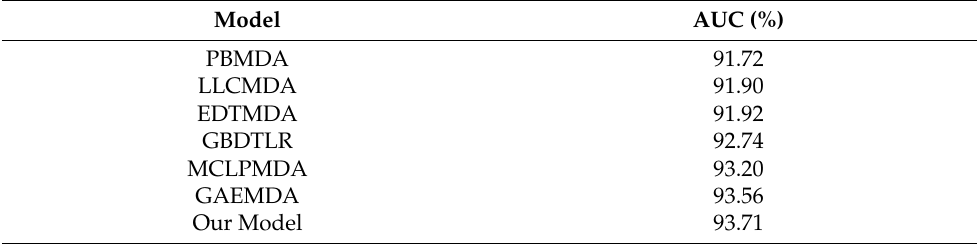
Table 1. Comparative analysis of our model and related